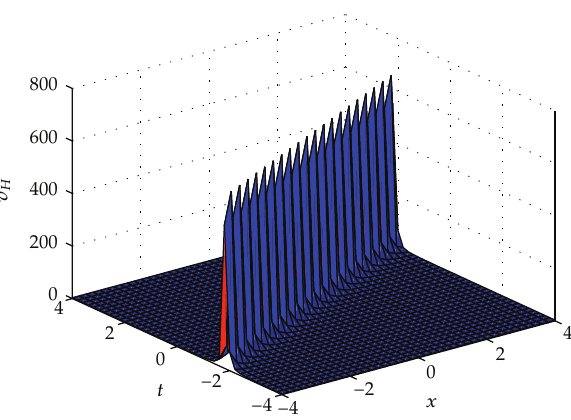
Figure 3: Soliton solution | v H (cid:4) x,t (cid:5) | of the Schr¨odinger-Boussinesq system, (cid:4) 3.12b (cid:5) , for α (cid:3) 1 , β (cid:3) 16 , k (cid:3) 1 , ω (cid:3) − 2, and ρ H (cid:3) tanh − 1 (cid:4) 1 / 4 (cid:5)